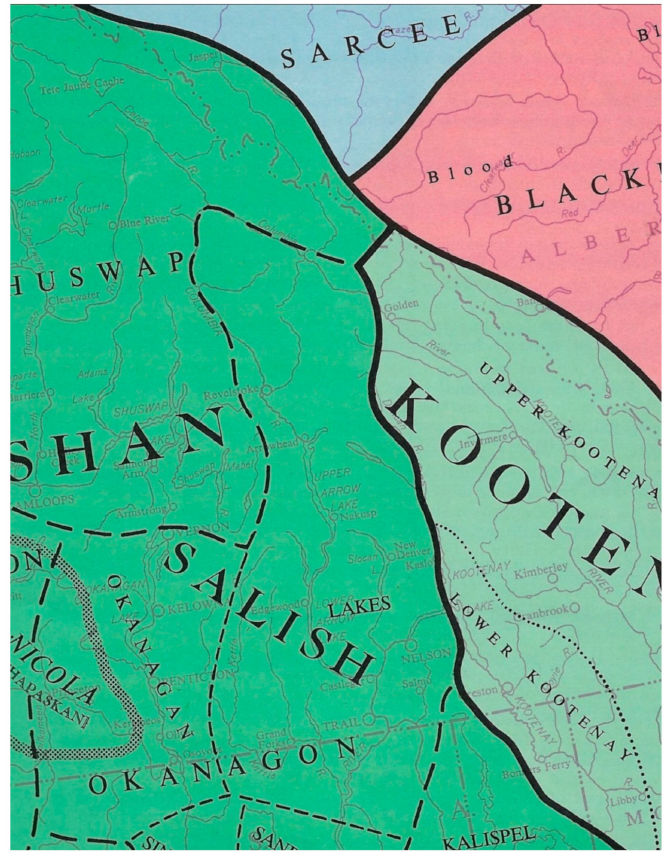
Figure 4. Sinixt (Lakes) as shown in Map 12 on pages 25–26 of the 1956 atlas created by the British Columbia Natural Resources Conference. The caption notes that the territory of the Lakes (Sinixt) is mapped as it existed in